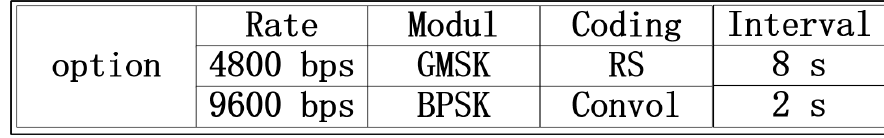
Figure 3. C ommunication mode option. Figure 3. Communication mode